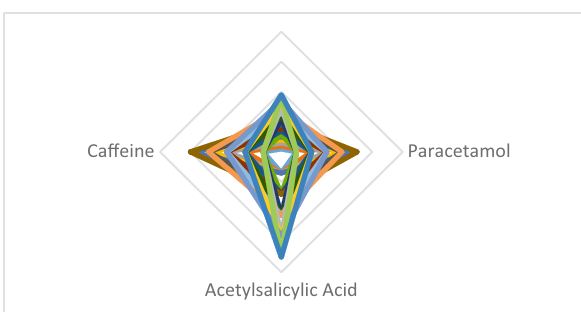
Figure 2: Concentration set design for the preparation of PCR and PLS calibrations.